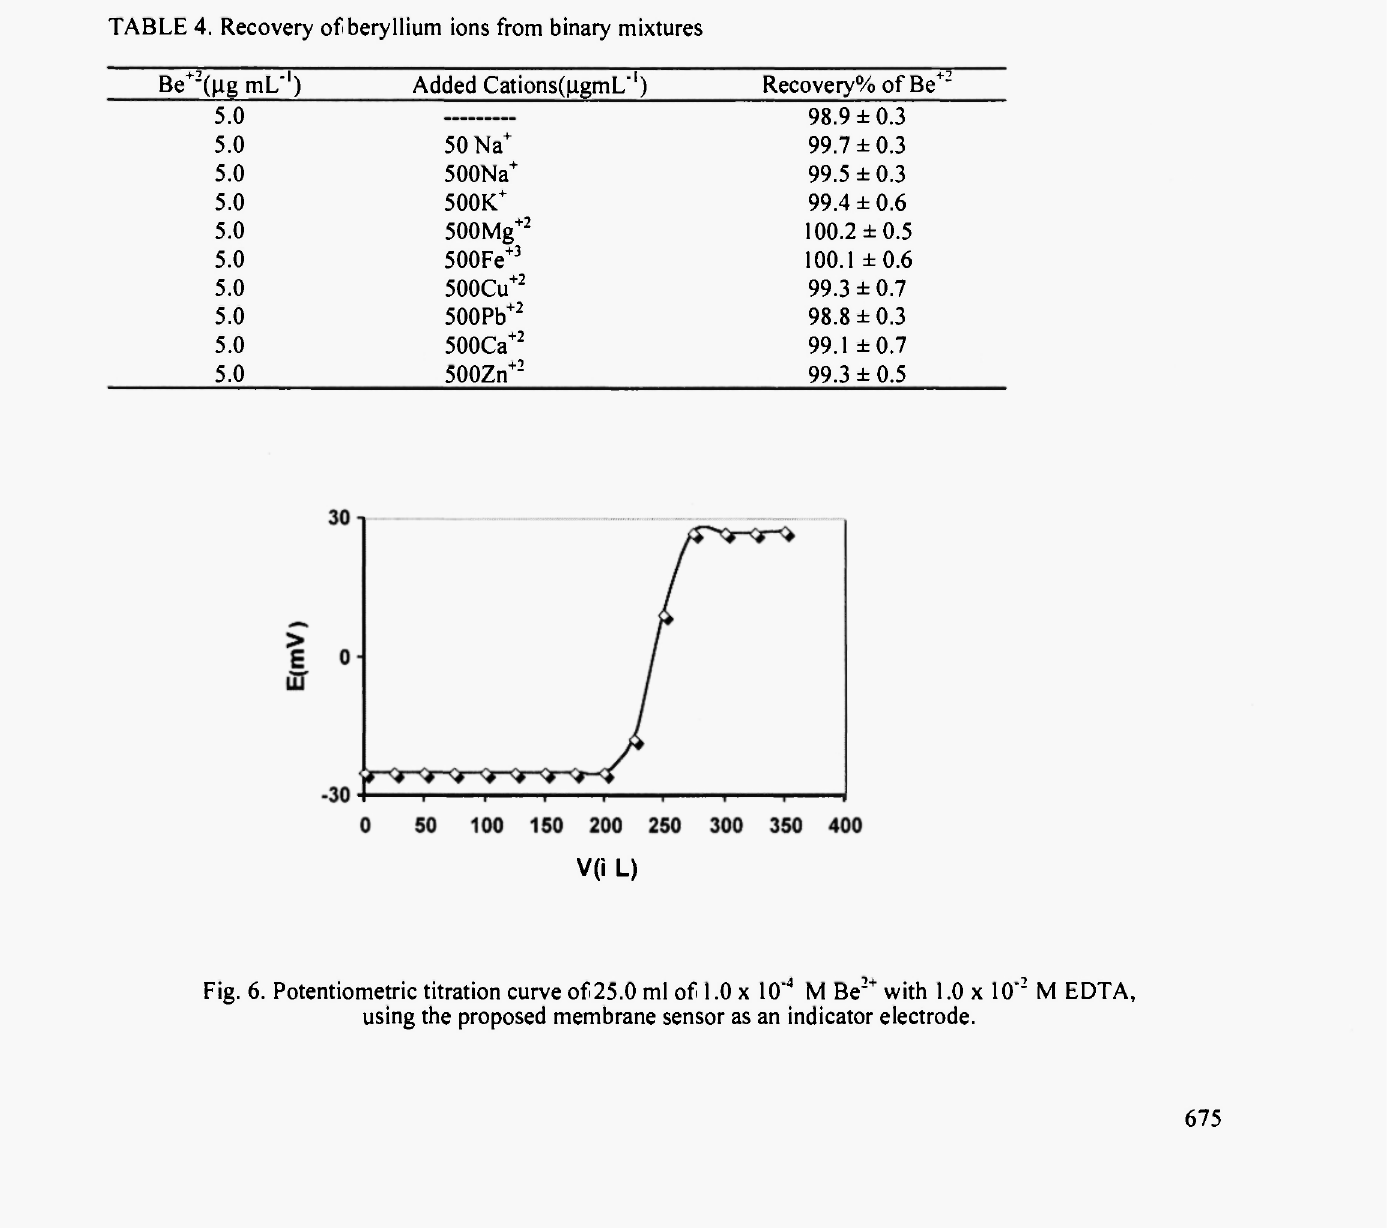
TABLE 4. Recovery of beryllium ions from binary mixtures